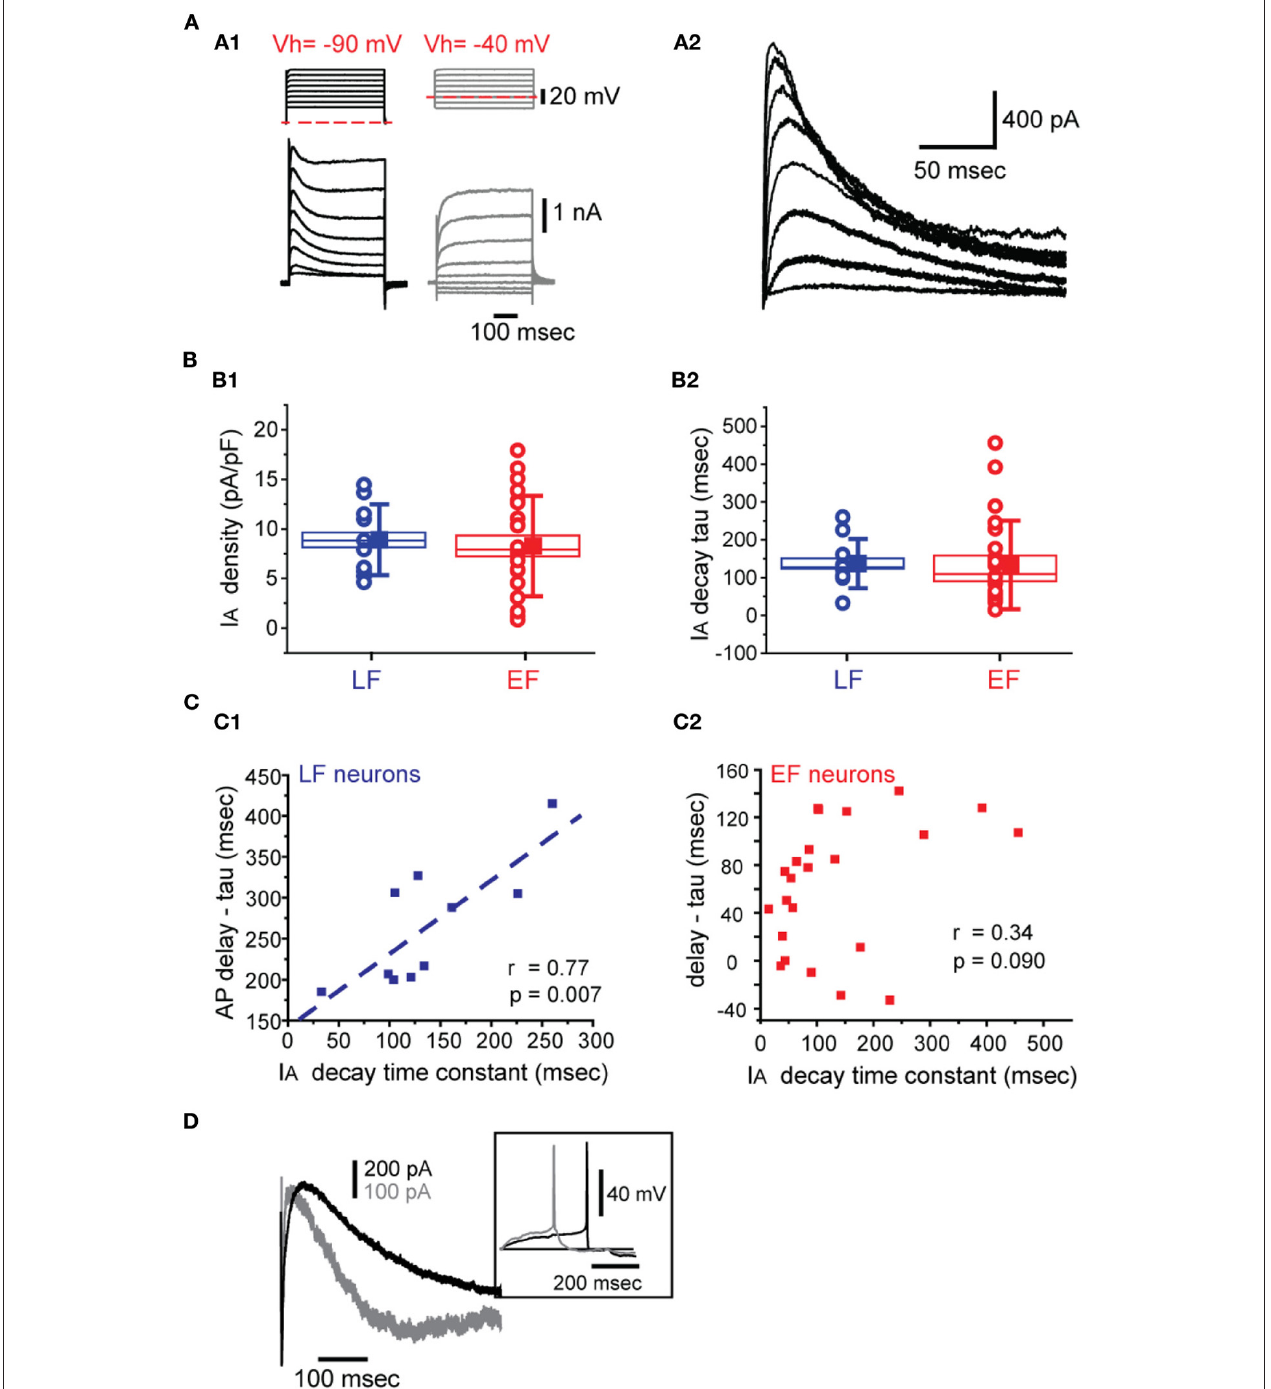
shown in blue and red, respectively. The box sizes indicate the standard error of the mean while whiskers indicate standard deviation. Circles indicate individual data points while the filled square shows the group means. (C) Spike onset correlations with I A decay time constants and membrane tau-corrected spike delays in LF (C1) and EF (C2) neurons. (D) Representative I A recordings from two LF neurons along with their current clamp recording of spiking activity (inset). The cell indicated by a darker trace has a slower inactivating I A along with a more pronounced spike